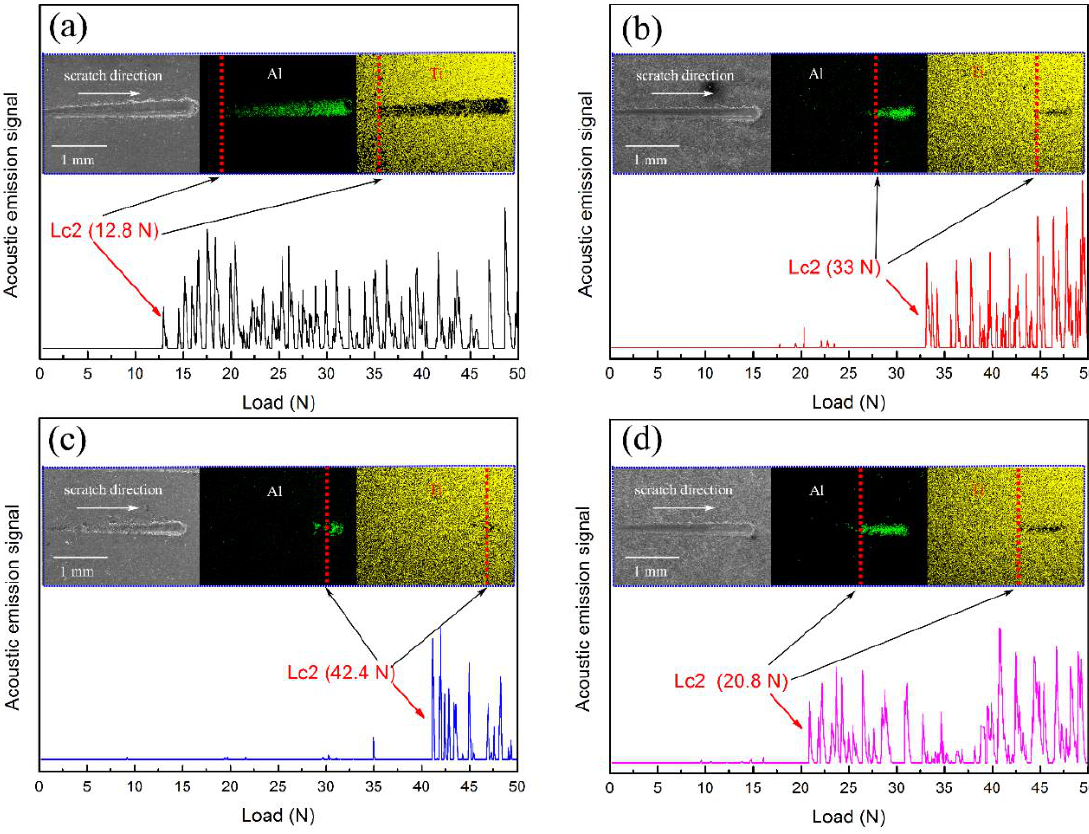
Figure 10. Scratch curves of acoustic signal, SEM images of scratch track and critical load values (Lc2) of Ti-DLC coatings with the Ti transition layer thickness ( t 0 ): ( a ) 0 μm, ( b ) 0.5 μm, ( c ) 1.1 μm and ( d ) 2.8 μm.